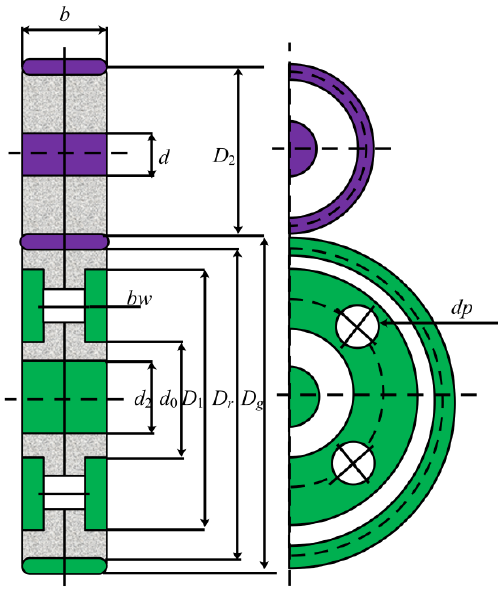
Figure 11. The construction of the four-stage gearbox design problem.